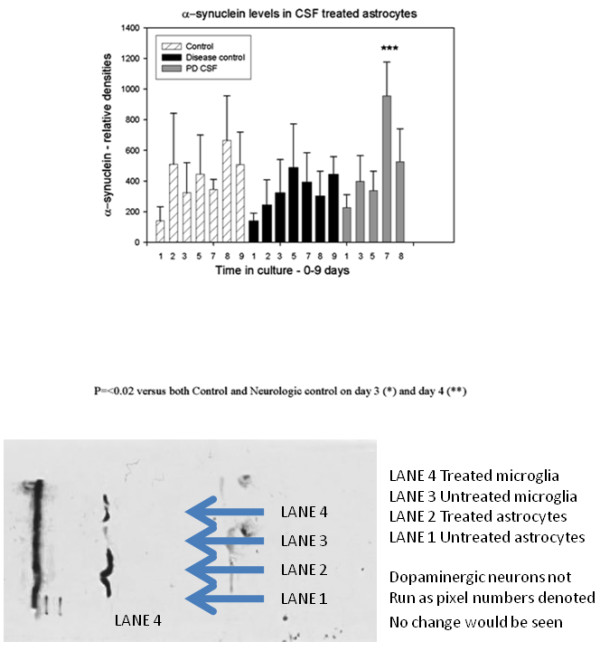
Histogram demonstrating changes in α-synuclein content of cultured astrocytes of all treatment groups over the course of the experiment. On day 7 there was a significant (p < 0.05) increase in α-synuclein content in the PD-CSF treated astrocytes, compared to the neurological disease control CSF treated cells, but all cells showed a trend to a return to baseline of α-synuclein content (n = 8). Western blot of protein levels is included for comparison.